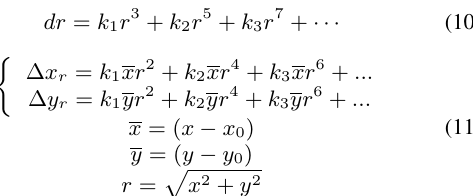
Figure 4: Expansive and contractive distortions of CCD linear array